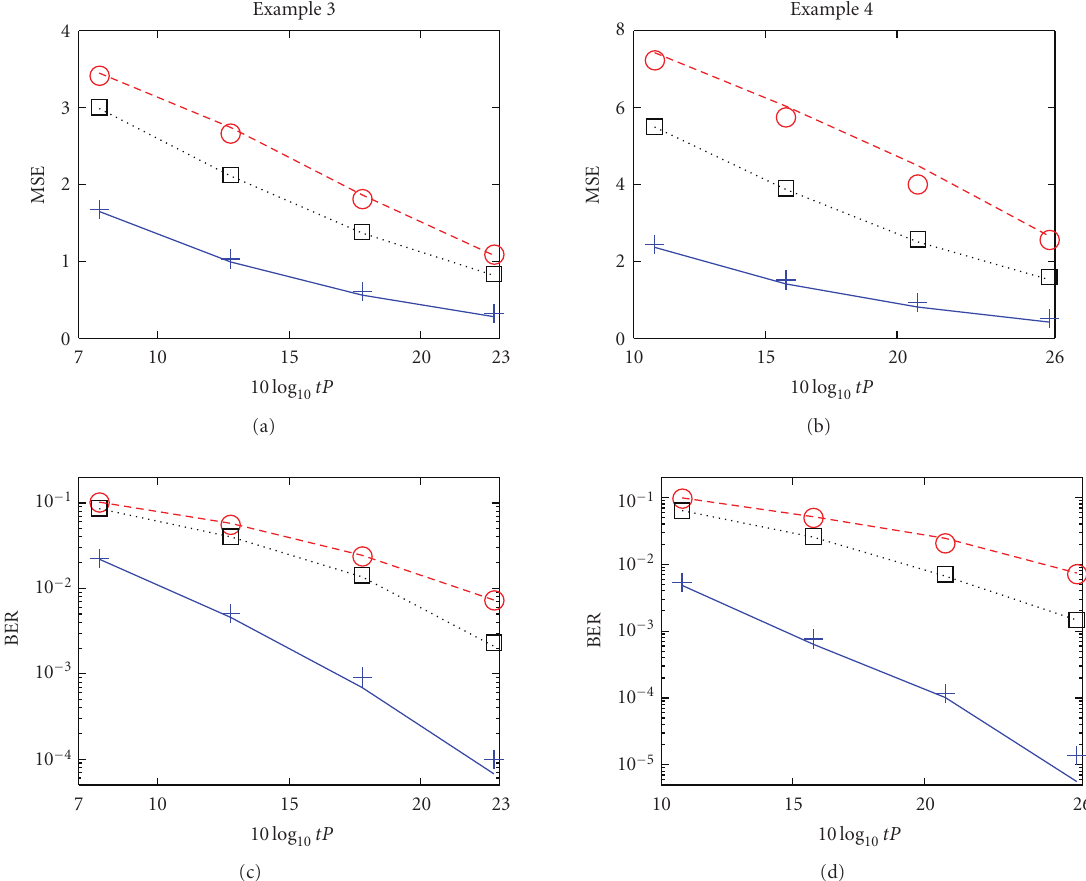
Figure 6: MSE and BER as functions of 10log Figure 1. ( Legends are the same as in Figure 5.